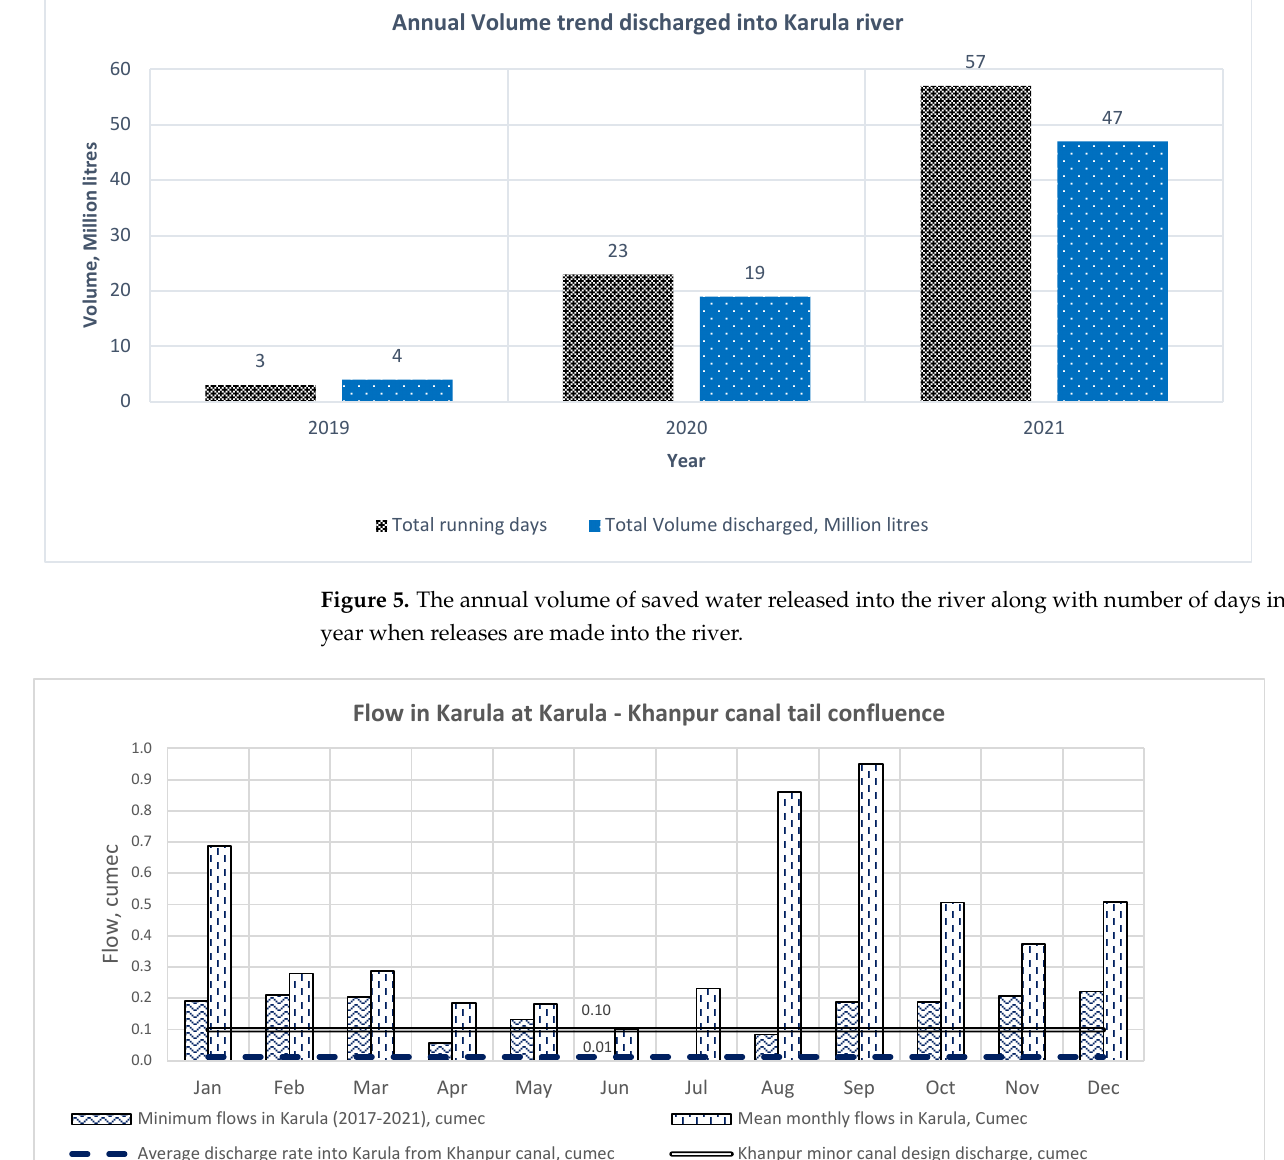
Figure 6. A snapshot of flow regime in Karula river and saved water from Khanpur Minor canal being discharged into Karula river.